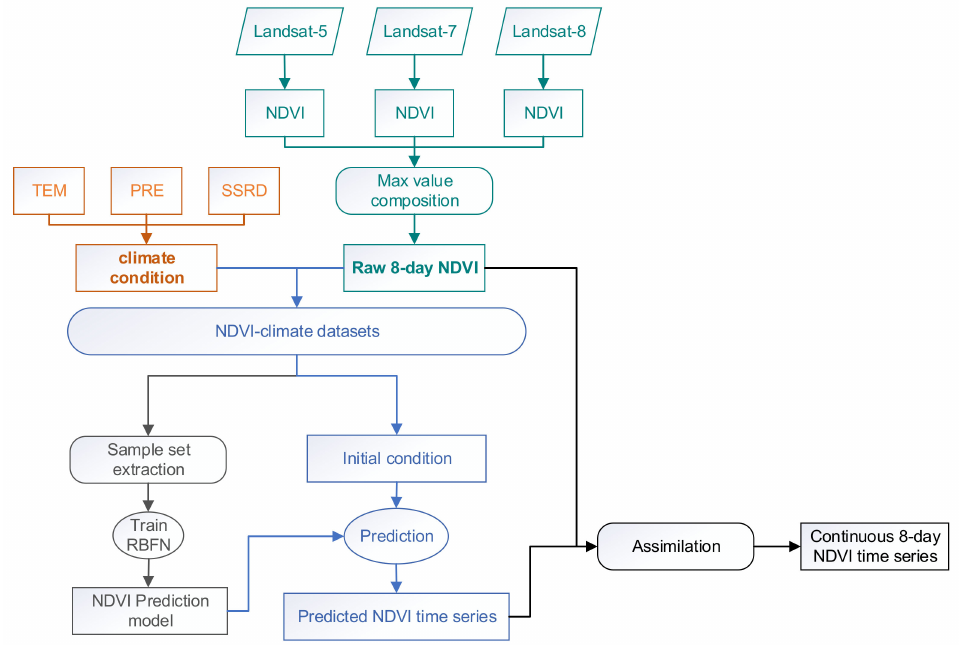
Figure 2. Conceptual framework of the reconstruction of the Landsat Normalized Difference Vegetation Index (NDVI) time